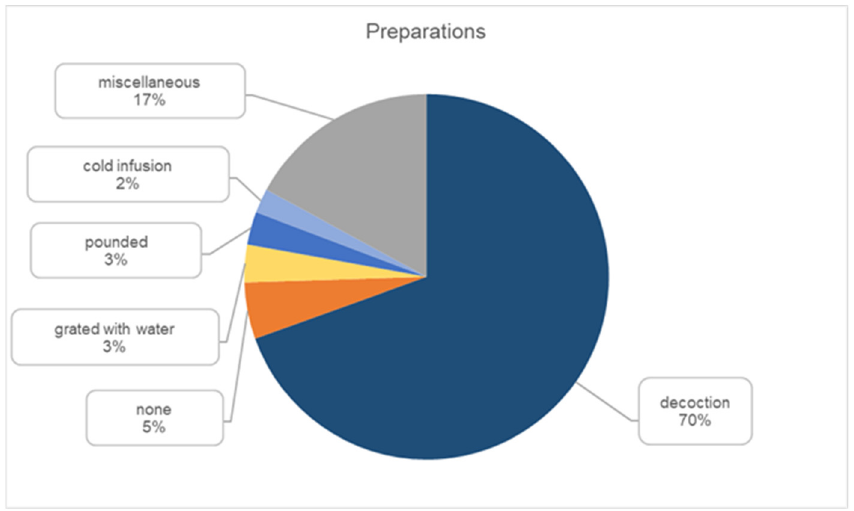
Figure 4. Percentages of use reports for different preparation methods of legume species in Thailand with medicinal uses, derived from 152 primary data sources produced from 1986–2019.